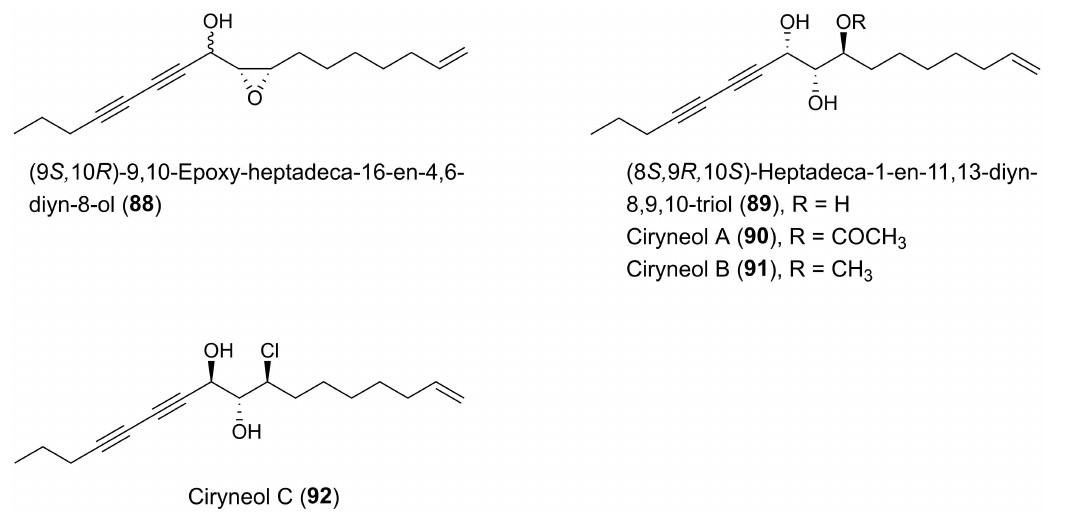
Figure 4. Cytotoxic C 17 acetylenic oxylipins ( 72 – 92 ) of the dehydrofalcarindiol-type. An asterisk (*) after a compound number, indicates a cytotoxic dehydrofalcarindiol-type polyacetylene of synthetic origin that is not naturally occurring, but which may prove to be present in plants.